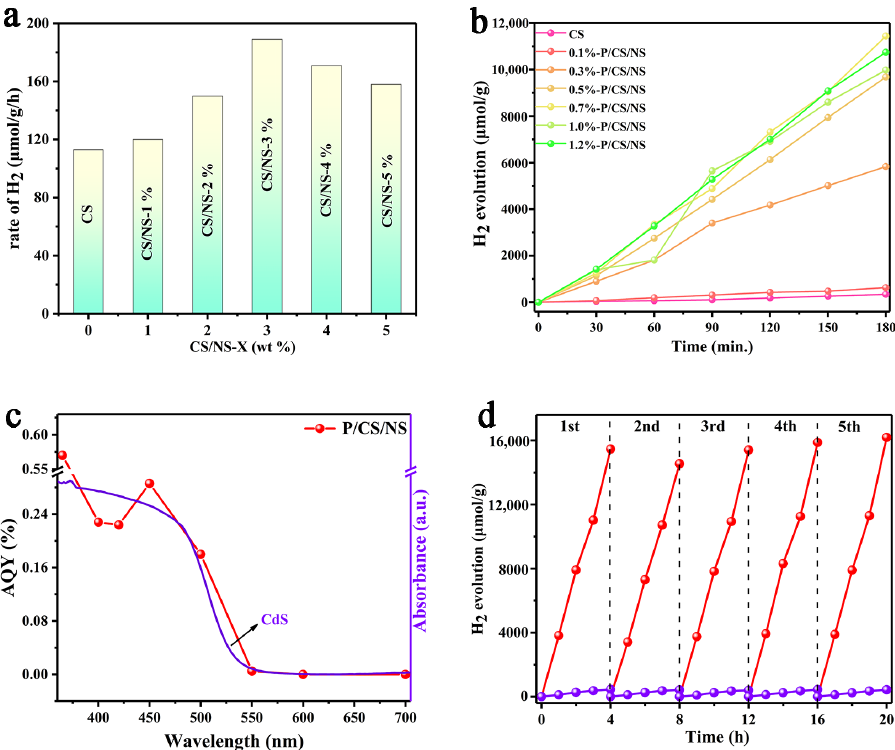
Figure 5. ( a ) H 2 evolution of CdS/NiS loaded with different ratios of NiS after 4 h of light irradiation ( λ ≥ 420 nm); ( b ) H 2 production in Pd/CdS/NiS-3% loaded with different ratios of Pd ( λ ≥ 420 nm); ( c ) The apparent quantum yield (AQY) of Pd/CdS/NiS; ( d ) Cycling stability test of Pd/CdS/NiS and CdS ( λ ≥ 420